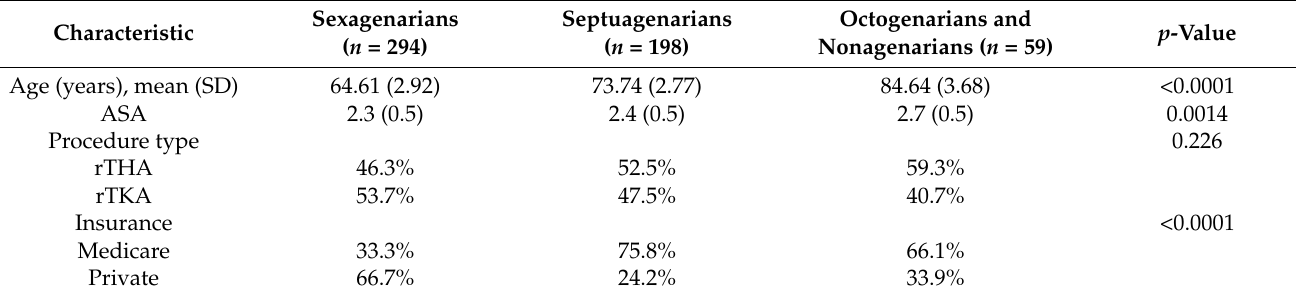
Table 1. Comparing patient characteristics for sexagenarians, septuagenarians, and octogenarians and older undergoing revision total hip or knee arthroplasty. ASA—American Society of Anesthesiologists classification, rTHA—revision total hip arthroplasty, rTKA—revision total knee arthroplasty.